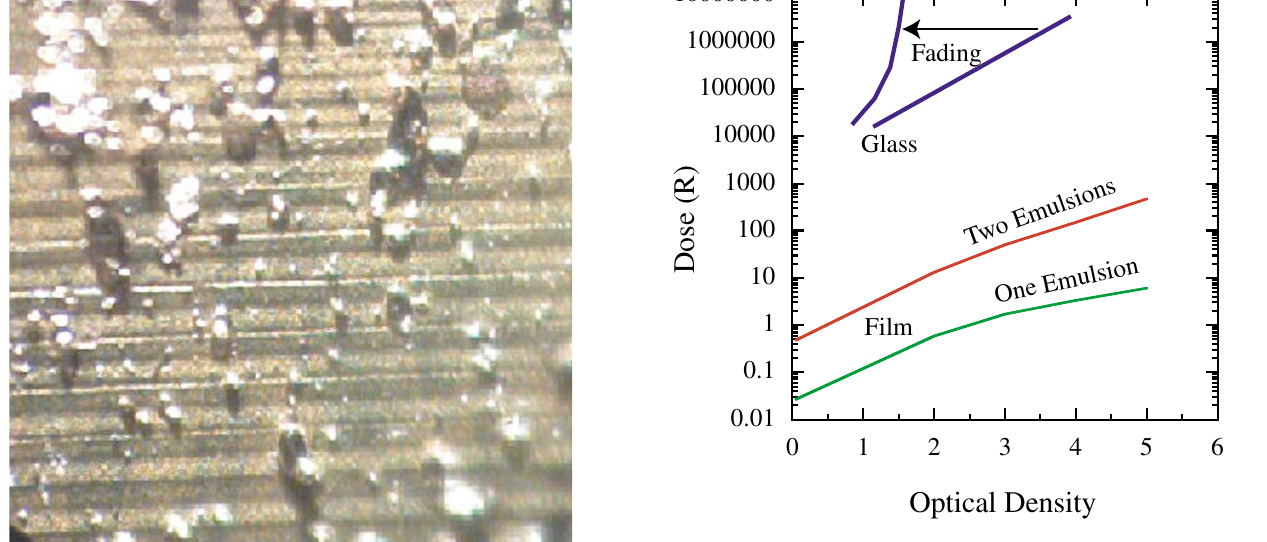
FIG. 24. (Color) A microscopic image of the center iris in the cavity, covering an area about 1000 (cid:2) 1000 (cid:16) m .